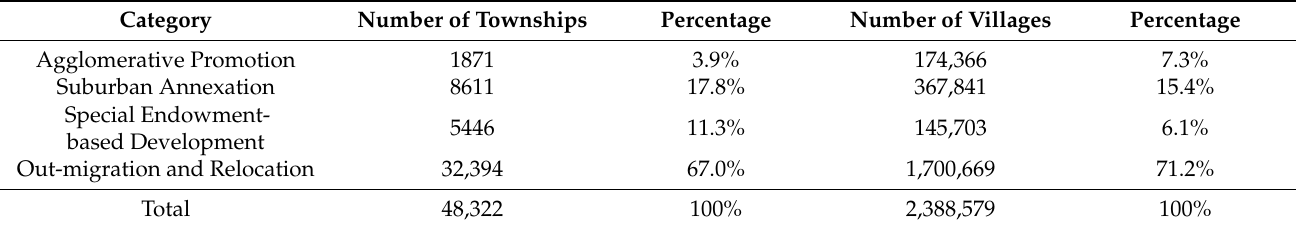
Table 2. Township and Village Counts of the Four Categories.